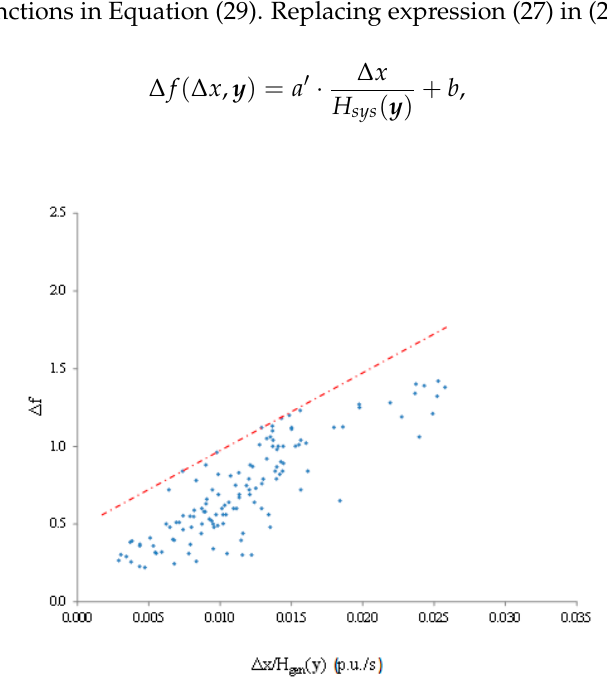
Figure 1. Maximum frequency deviation as a function of ∆ x / H sys